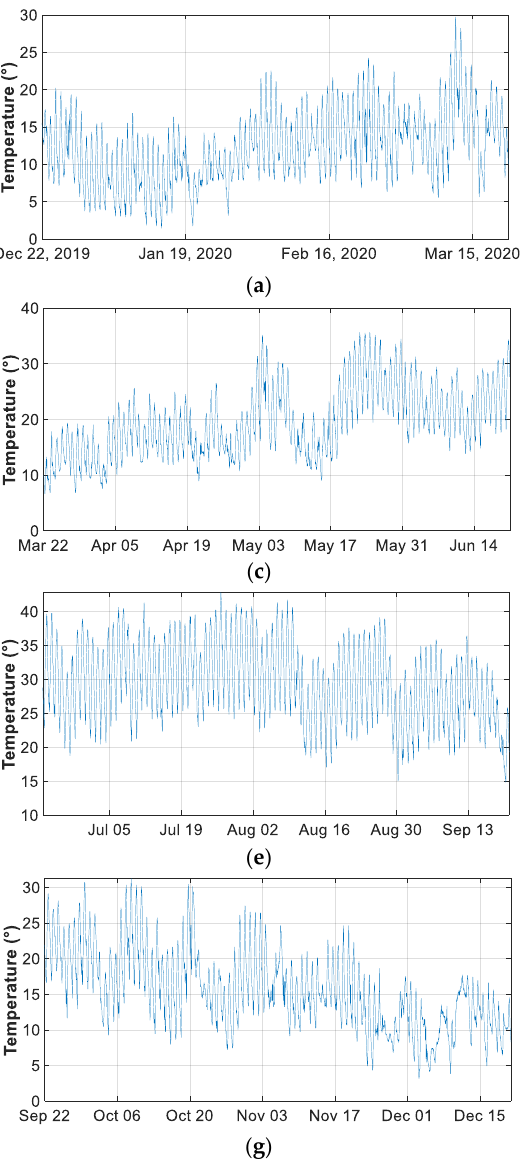
Figure 20. Temperature and humidity graphs for the year 2020: ( a ) temperature in winter; ( b ) humidity in winter; ( c ) temperature in spring; ( d ) humidity in spring; ( c ) temperature in summer; ( f ) humidity in summer; ( g ) temperature in autumn; and ( h ) humidity in autumn.